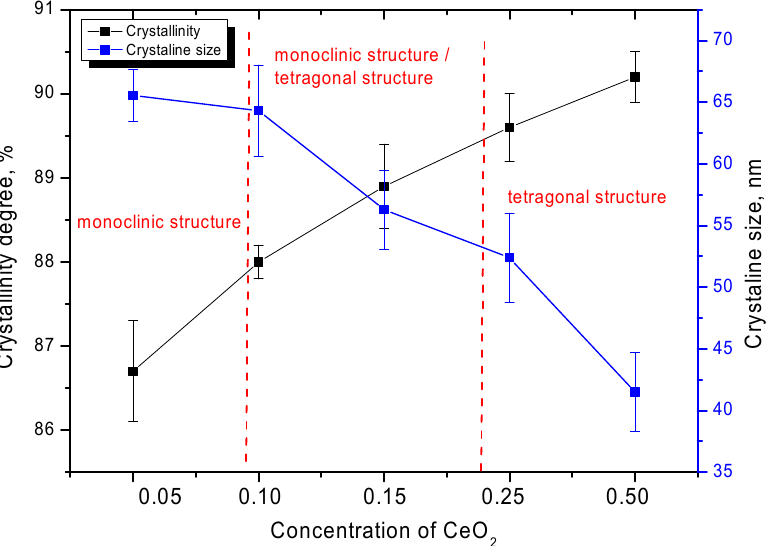
Figure 4. Dependences of the change in the crystallinity degree and crystallite sizes on the CeO 2 concentration in the composition of ceramics.